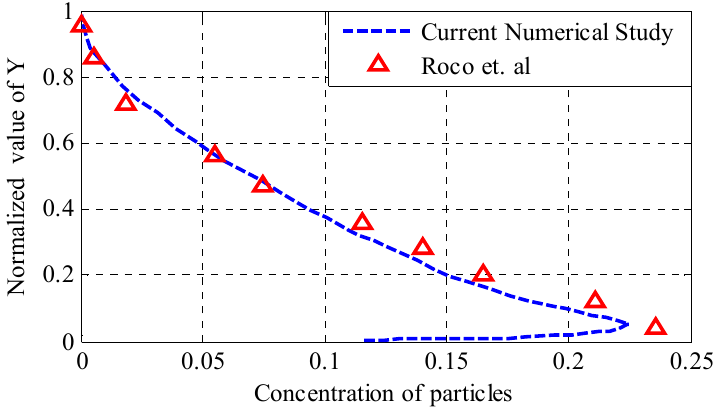
Figure 4. Comparison of numerical and experimental results for the concentration of particles.